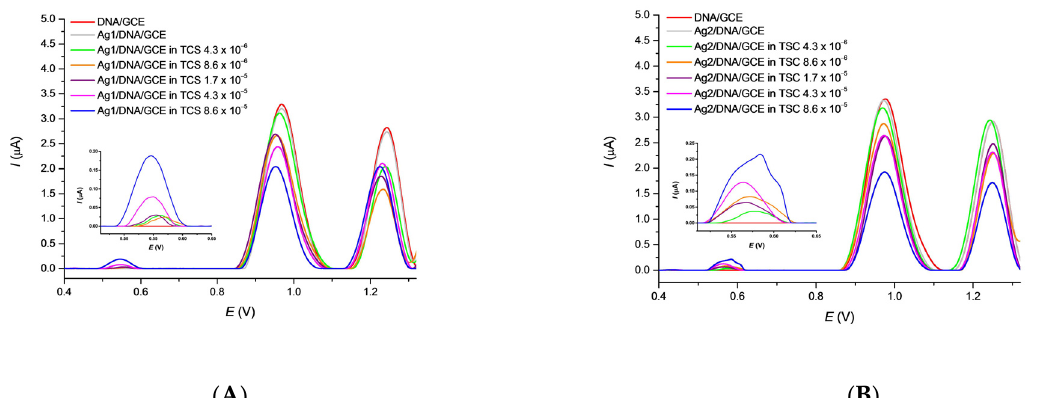
Figure 4. This SWV curves recorded after 15 min. incubation of the Ag1/DNA/GCE (A) and Ag2/DNA/GCE (B) biosensors in TCS solutions of various concentration in 0.1 mol·L − 1 PB pH 7.4. SWV conditions: amplitude 20 mV, frequency 50 Hz, step potential 4 mV and scan rate 200 mV·s − 1 .